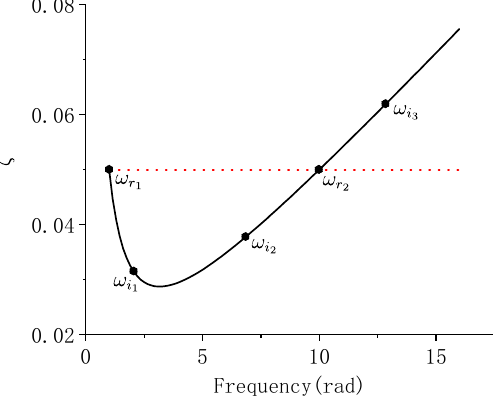
Figure 1. (cid:2033) (cid:3045) The smallest possible value is min